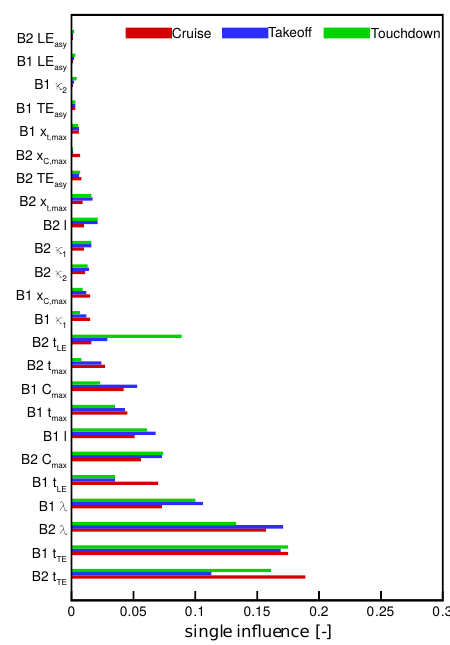
Figure 5. Pareto chart of the pressure rise coefficient ∆ p of blade 1 for all three operating points. This similar behavior can be explained by comparable flow conditions (Figures 2 and